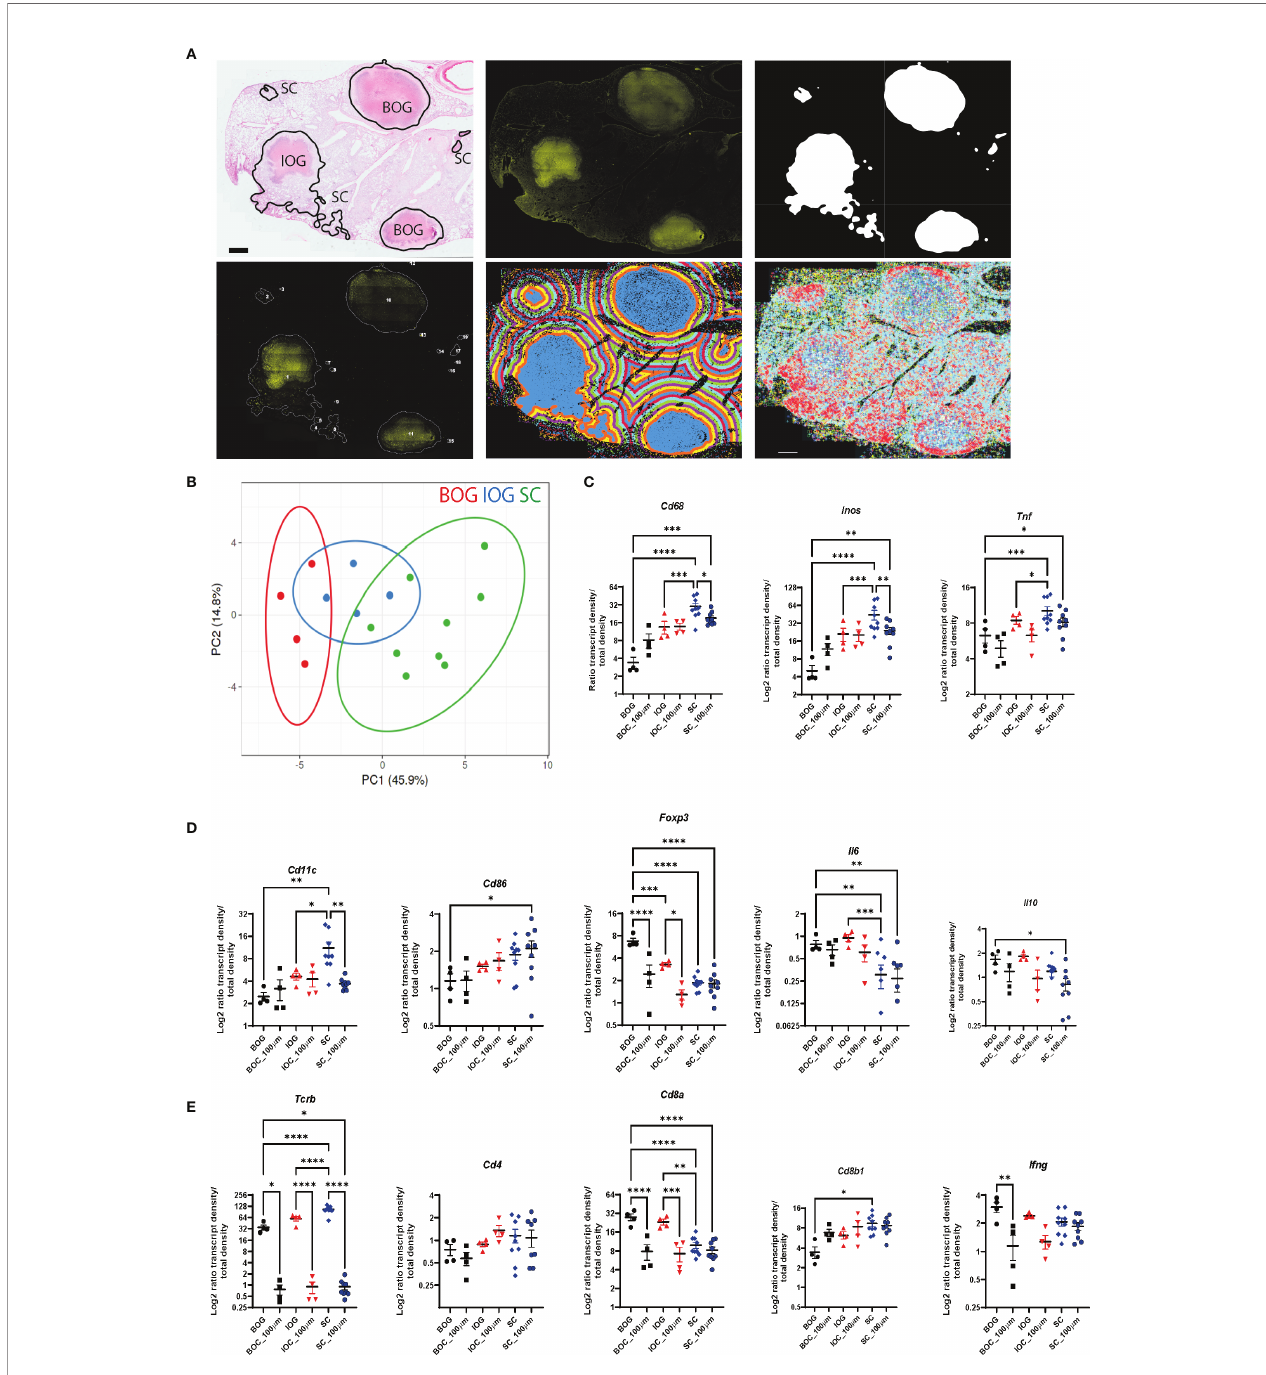
FIGURE 6 | Bacteria cluster types and their immune environment in C3HeB/FeJ mice at d(0) and d(100). (A) Annotation of cluster types shown on HE image to show the underlying histopathology for one representative C3HeB/FeJ section at 10 wpi (top panel, left). Classi fi cation into BOG, big organized granulomas, IOG, intermediate organized granulomas (less pronounced encapsulated structure), and SC, small cluster. Exemplary input and output of bacteria cluster pipeline with AR image (top middle) and cluster identi fi cation on the 20% subtracted image (top right). Lower panel displays cluster labeling for individual cluster analysis (left), the applied 100- m m gradient around identi fi ed clusters (middle), and plotted immune transcripts (right). Scale bar: 1,000 m m. (B) Principal component analysis displays the density ratio of immune transcripts in bacteria clusters identi fi ed across 3 sections for BOG (red, n = 4) IOG (blue, n = 4), and SC (green, n = 9). The ellipse around the clusters indicates the area in which 95% of the samples would be located based on gaussian distribution. (C – E) Density ratios for indicated transcripts of the same clusters as in (B) are displayed. The mean of transcript densities in the bacteria cluster (d0) and in the 100- m m (d100) surrounding area was calculated. Displayed transcripts in (A) Cd68, Inos , and Tnf ; (B) Cd11c, Cd86, Foxp3, Il6 , and Il10 ; and (C) Tcrb, Cd4, Cd8a, Cd8b1 , and Ifng . Mean density ratios ± SEM and individual values are shown, and signi fi cant differences are indicated (ANOVA, * for p < 0.05, ** for p < 0.01, *** for p < 0.001, and **** for p <